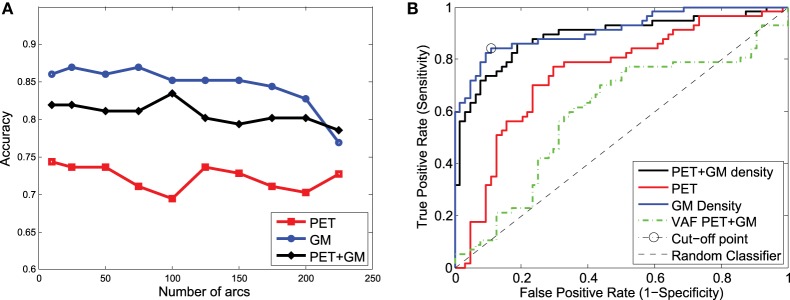
Accuracy (A) and ROC curve (B) for CN/MCI classification considering a different number of arcs in the SICE.